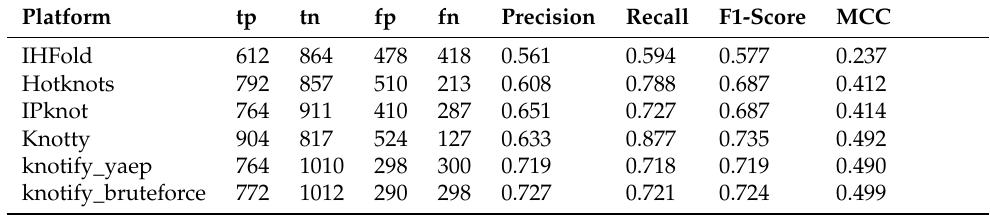
Table 8. Precision, recall, F1-score, and MCC per platform for sequences of length >= 40 and < 50.